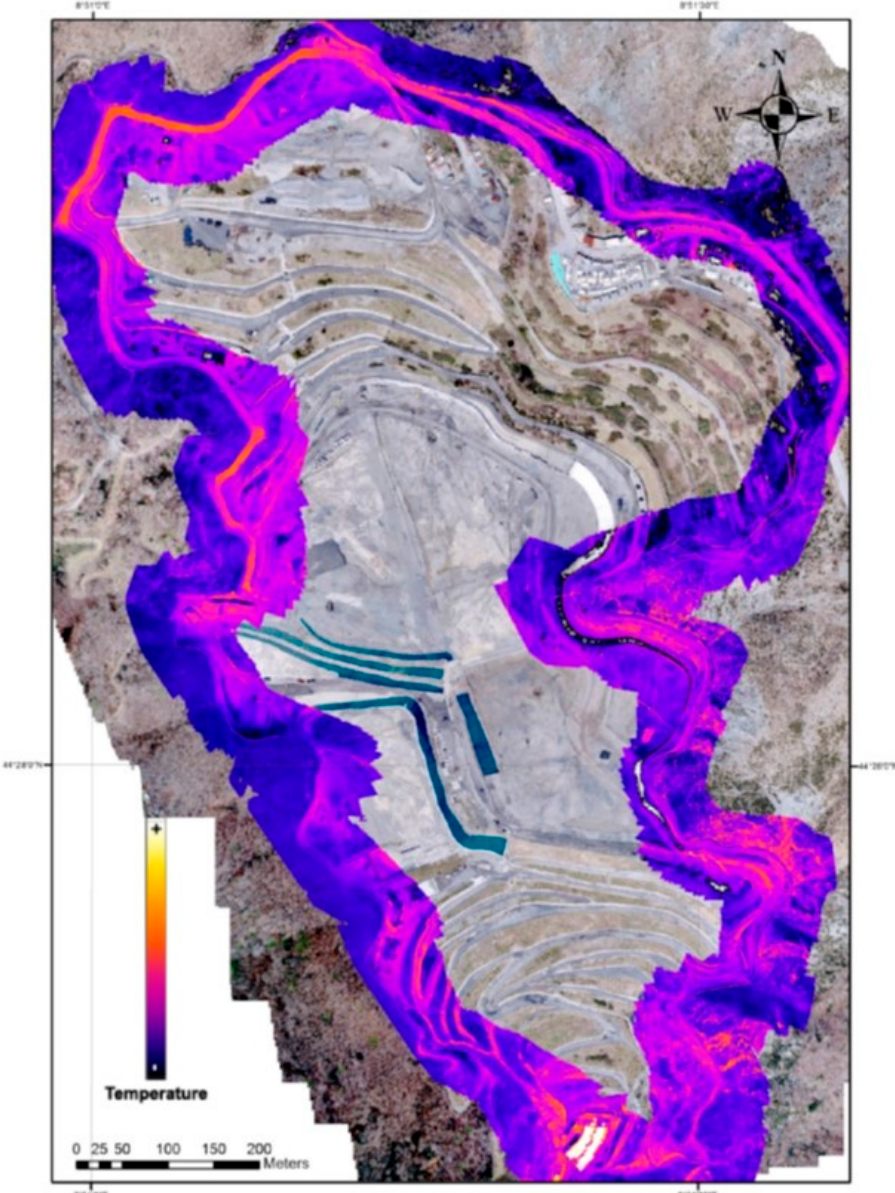
Figure 3. Mosaic image of the landfill (Mount Scarpino) containing the topographic view of the entire site and the infrared (IR) imaging of the peripheral region.